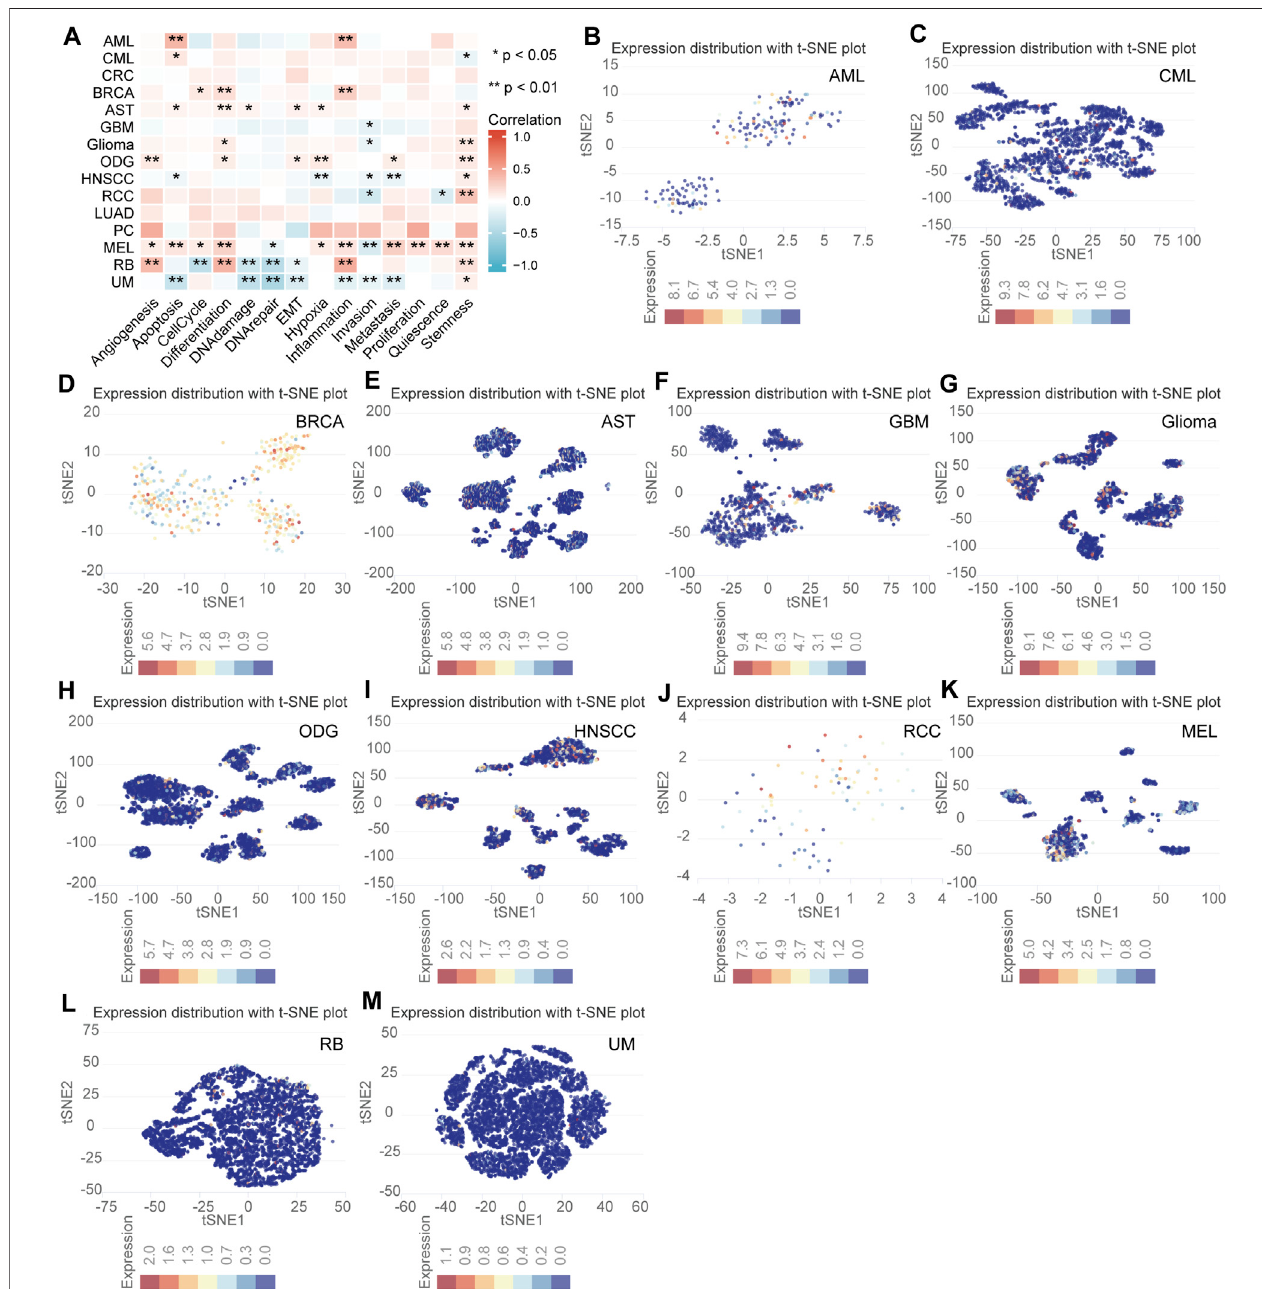
FIGURE 9 | The correlation analysis of NFE2L3 expression and single cell functional status in multiple tumors. (A) Heat map of correlation between NFE2L3 expression and single cell function in multiple tumors. (B – M) T-SNE diagram of NFE2L3 expression levels in single cells of multiple tumors including acute myeloid leukemia (AML), chronic myelogenous leukemia (CML), breast cancer (BRCA), astrocytoma (AST), glioblastoma (GBM), glioma, oligodendroglioma (ODG), head and neck cancer (HNSCC), renal cell carcinoma (RCC), melanoma (MEL), retinoblastoma (RB), and uveal melanoma (UM).